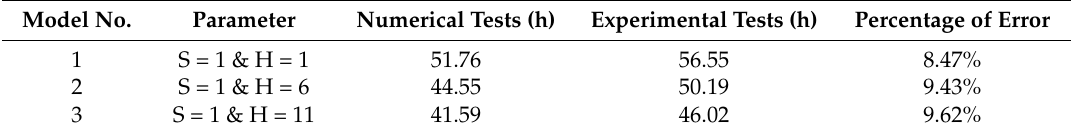
Figure 6. Distribution of average heat transfer coefficient (Experimental and numerical values) at nozzle-nozzle spacing = 1 cm and the distance between nozzle-plate = 1, 6 and 11 respectively. Table 2. Error Percentage of heat transfer coefficient (h) between the Numerical and Experimental tests. Model